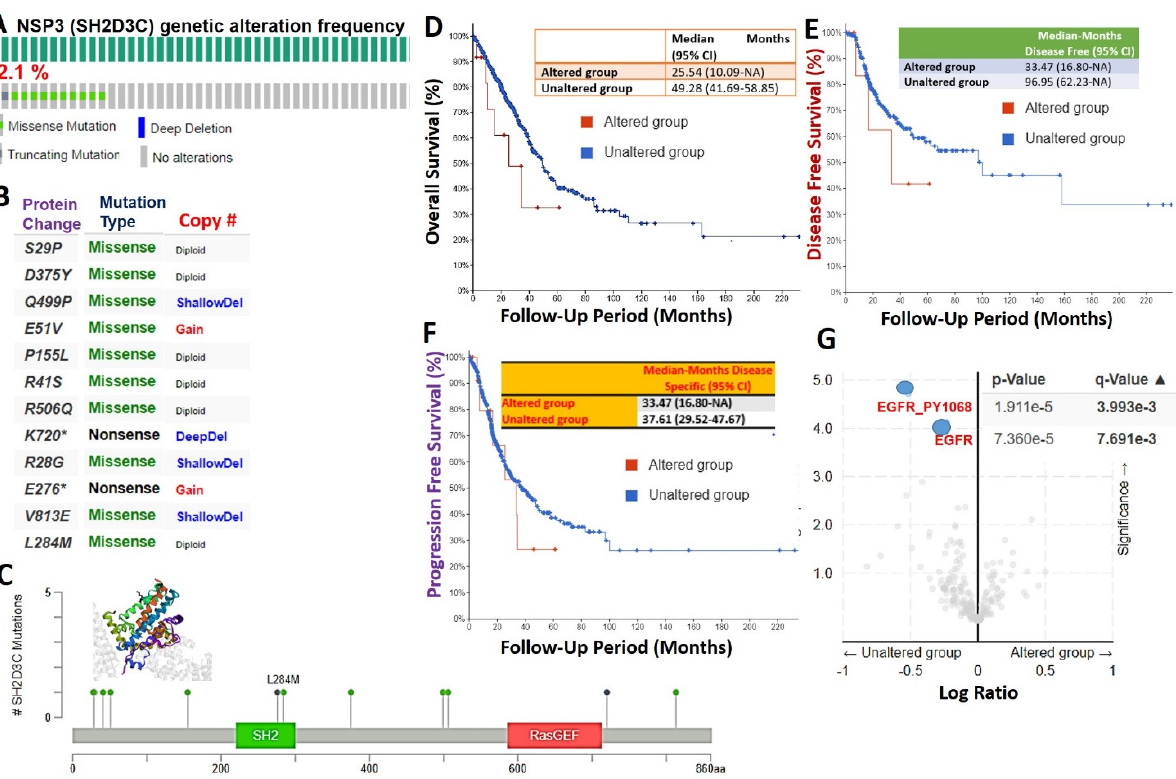
Figure 2. Genetic alterations of non-structural protein 3 ( NSP3; SH2D3C ) are associated with poorer prognosis and inversely associated with Epidermal Growth Factor Receptor ( EGFR ) alterations in lung cancer patients. Genetic alteration profile of NSP3 (SH2D3C) in lung adenocarcinoma. ( A ) Prevalence and distribution of NSP3 (SH2D3C ) genetic alterations in lung adenocarcinoma cohort. ( B ) Specific mutation types of NSP3 (SH2D3C ) in lung adenocarcinoma cohorts. ( C ) Lollipop plot of NSP3 (SH2D3C) mutation location in lung adenocarcinoma cohort across the cBioPortal for Cancer Genomics dataset. Mutations are color-coded as missense, truncating, and in-frame mutations. ( D ) Kaplan–Meier plot of the ( D ) shorter overall survival ( E ), disease-free survival, and ( F ) progression-free survival between lung cancer cohorts with genetically altered and cohorts without altered NSP3 (SH2D3C). ( G ) Heat map of NSP3 (SH2D3C ) mutation co-occurrence in lung cancer patients.